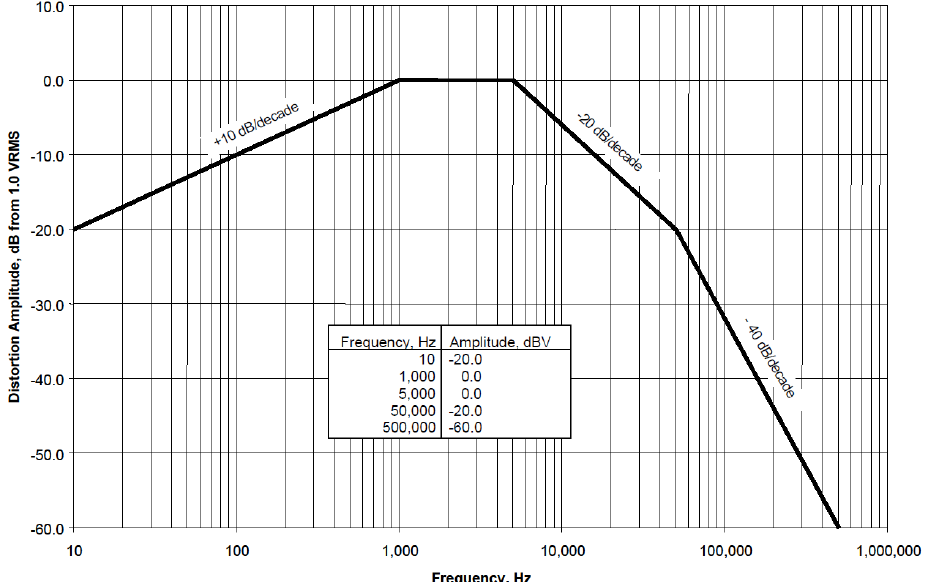
Figure 7. Profile of harmonic and supraharmonic network limits for avionics, as per MIL-STD-704F [107], DC bus 28 Vdc (for the 270 Vdc bus limits are 10 dB higher).